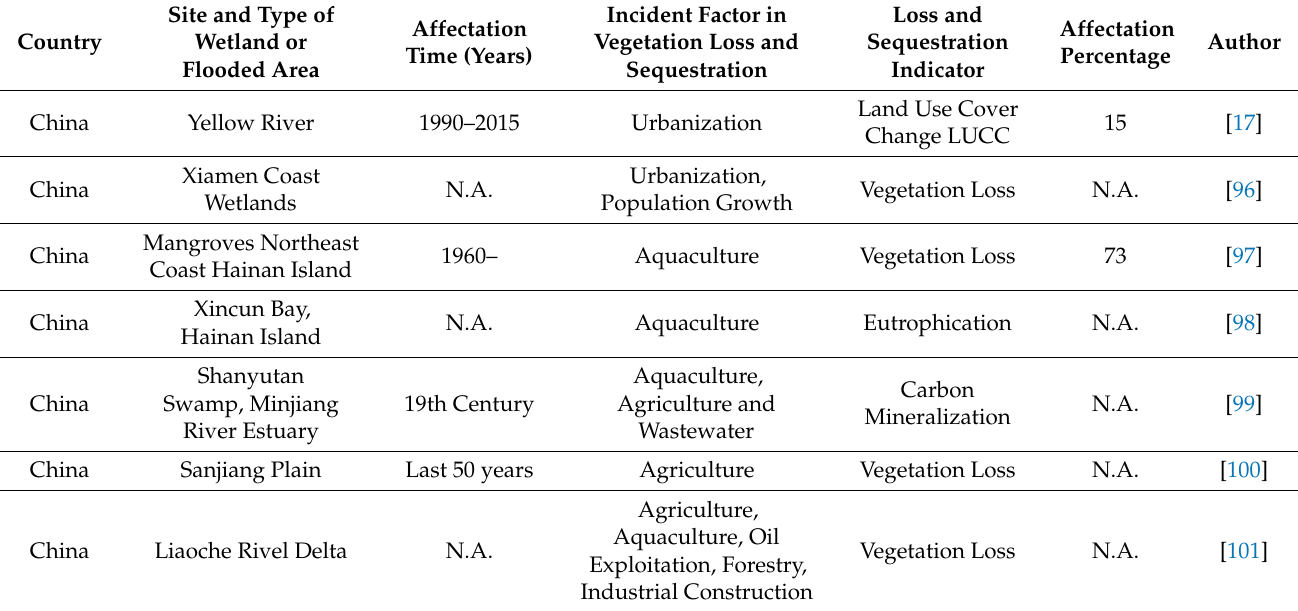
Table 3. Data from the Asian continent on wetlands in coastal, marine, and continental zones (n =